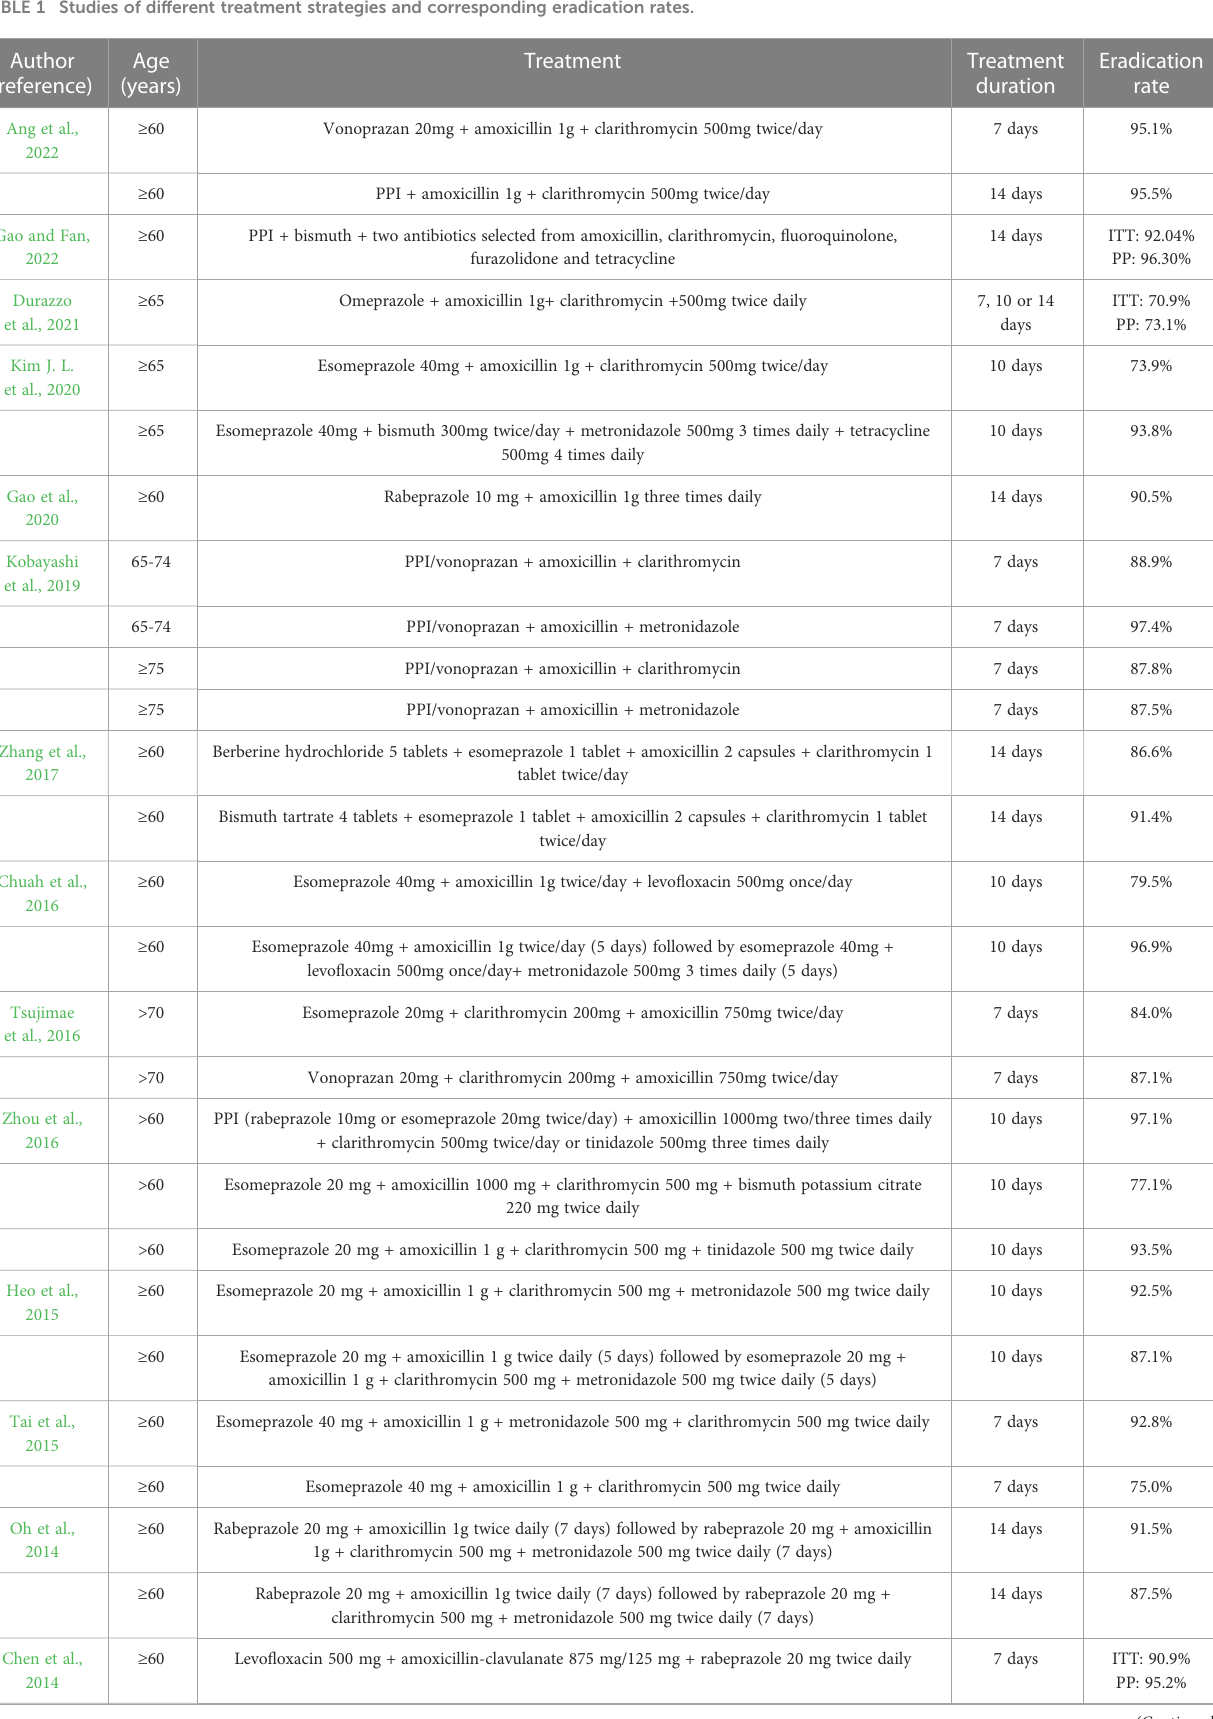
TABLE 1 Studies of different treatment strategies and corresponding eradication